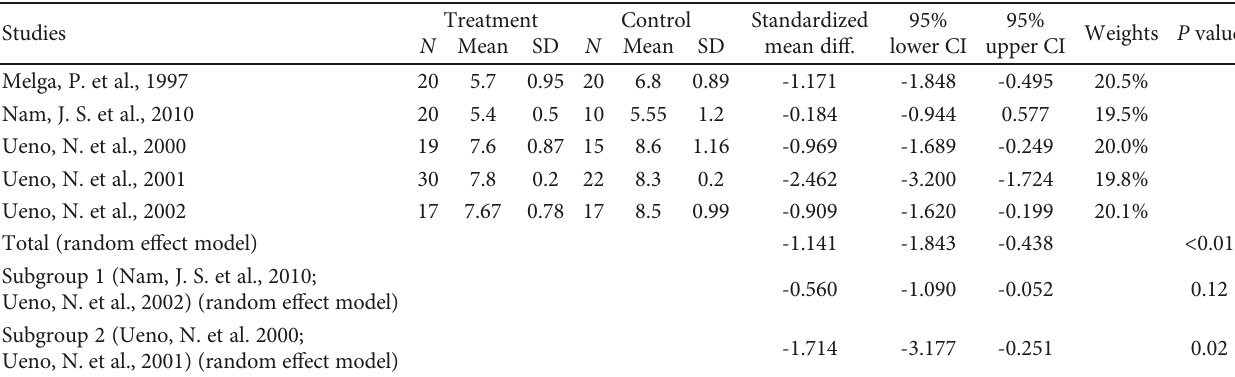
Table 3: The results of meta-analysis for